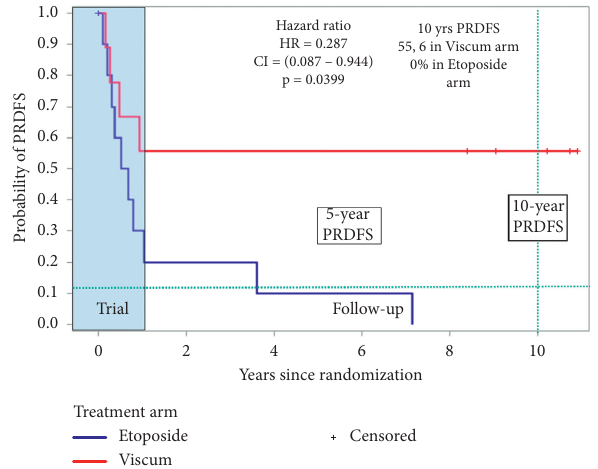
Figure 1: Postrelapse disease-free survival.